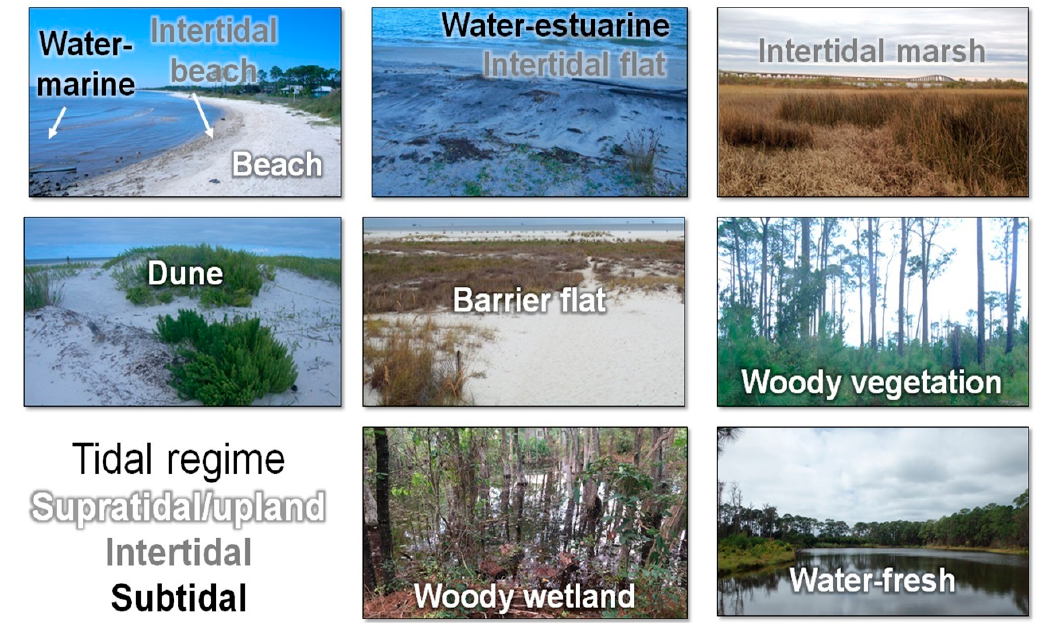
Figure 3. Examples of the habitat classes for the barrier island habitat modeling effort on Dauphin Island, Alabama, USA. The classes are linked to tidal regime (see legend in lower left corner of the figure). The developed class was not shown since it was not explicitly modeled in this effort. Adapted from Enwright et al. [28] with permission.